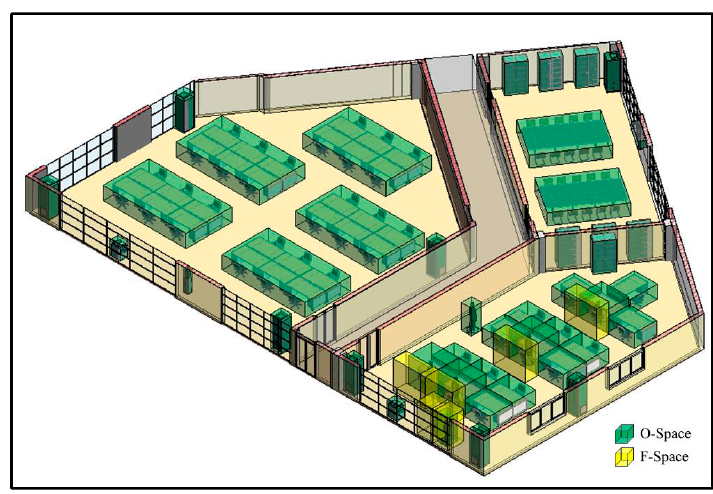
Figure 12. The indoor spaces that participate in the navigation for a non-disabled adult male.